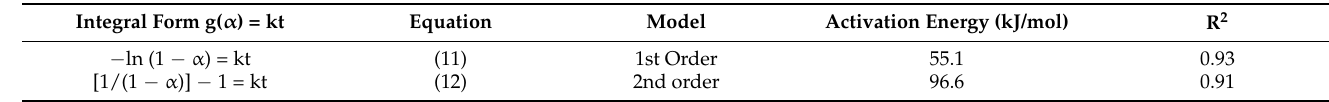
Figure 20. Arrhenius plot of different reaction orders under H 2 reduction.